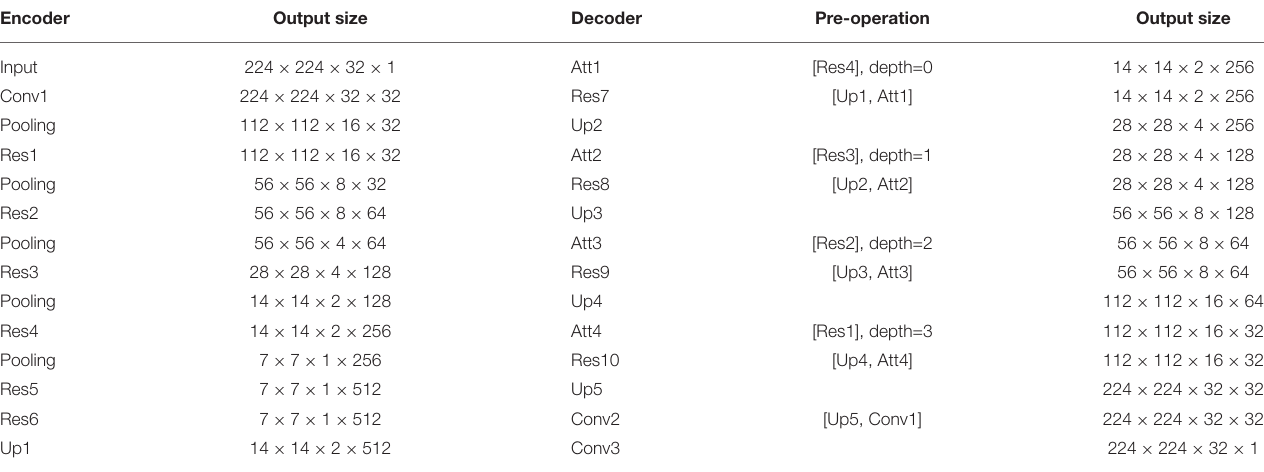
TABLE 2 | Architecture of the proposed RA-UNET-II in liver localization stage. Encoder